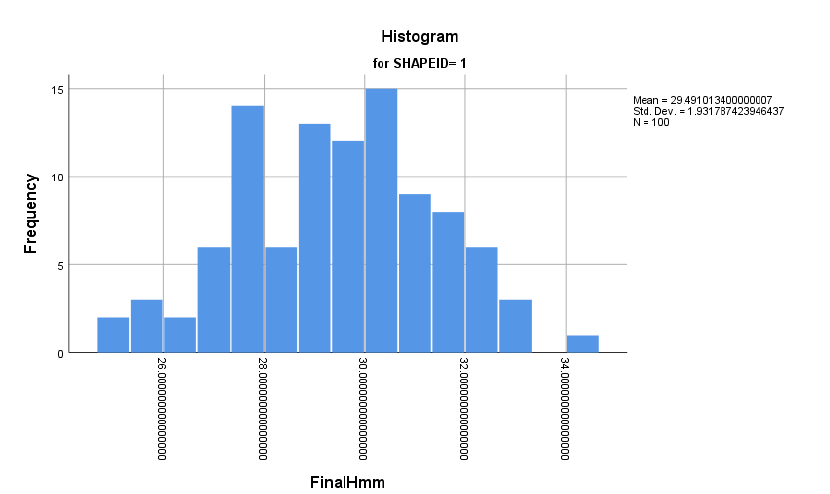
Figure A3. Shrink height adjustment for 30 mm.